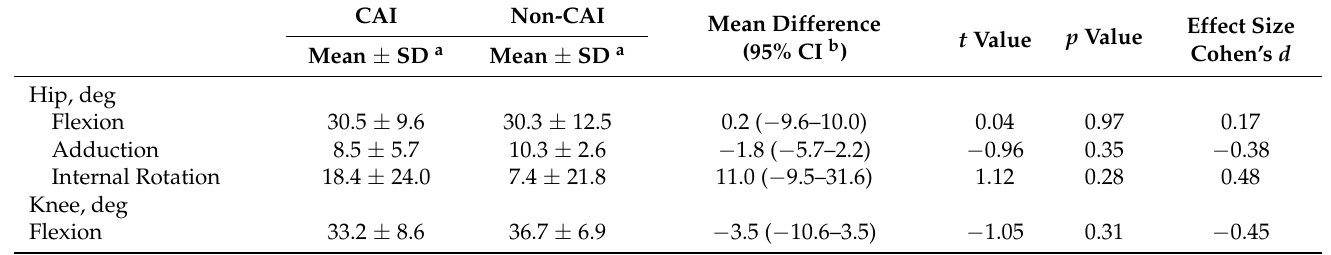
Table 3. The maximum values of the lower-extremity kinematics of the CAI and the Non-CAI groups.